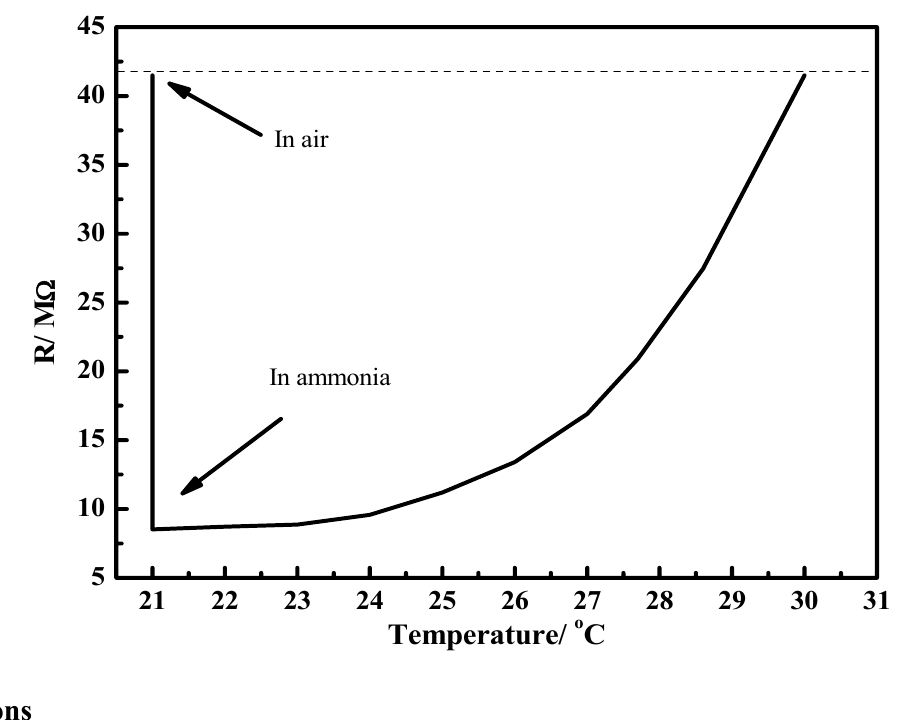
Figure 15. Variation in resistance of the ZnO sensor as a function of temperature in the presence of 590 ppm ammonia in the